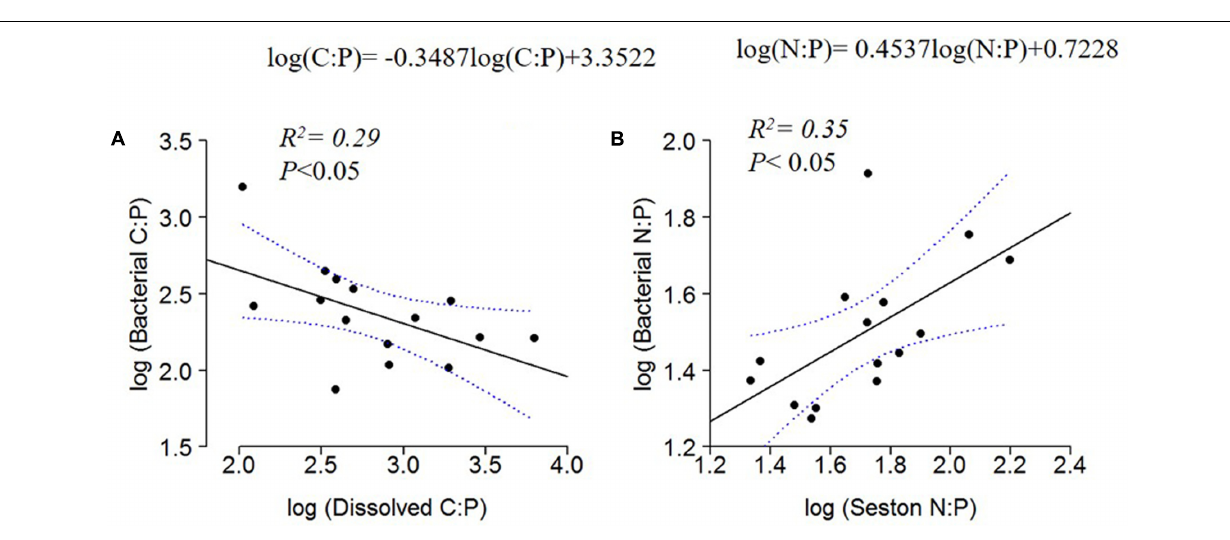
FIGURE 6 | Log 10 linear regressions of bacterial C:P against dissolved C:P (A) and bacterial N:P against seston N:P ratio (B) . The regression fit is indicated by black solid lines and 95% confidence intervals by blue dotted